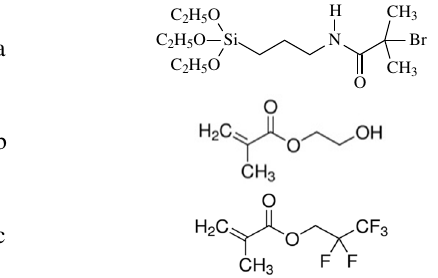
Fig. 1: Chemical structure of (a) silane bearing ATRP initiator, (b) HEMA and (c) PFPMA